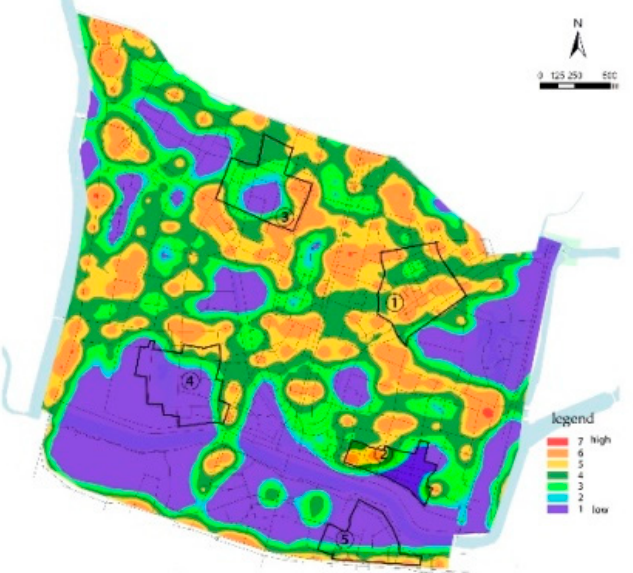
Figure 4. Vectorized and value-assigned Baidu heat map data (noon, 1 October 2021).